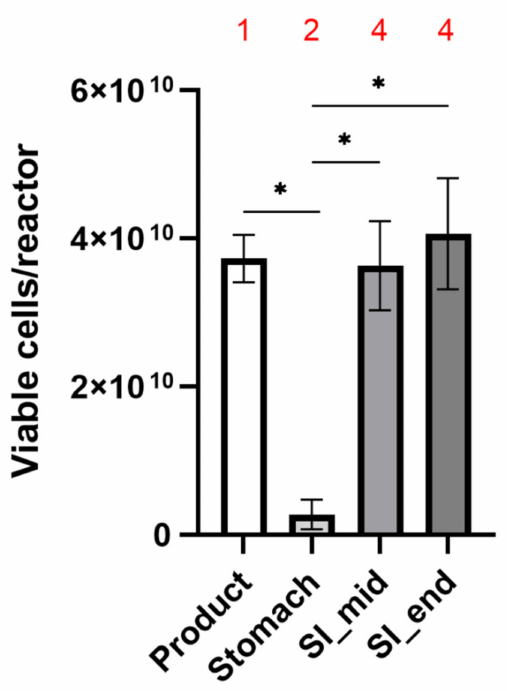
Figure 2. Probiotic survival during the upper gastrointestinal digestion in vitro. Bars represent the mean viable count ± SD ( n = 3) of microbial cells obtained by double live/dead staining and flow cytometry in the product and at different gastrointestinal compartments of the simulated digestion. SI mid = conditions mimicking middle of the small intestine; SI end = conditions mimicking the end of the small intestine. Statistically significant differences in different samples are indicated with asterisks (* p < 0.001). The visual scores of the capsules are indicated above the bars in red: (1) capsule intact; (2) capsule starting to degrade but most bacteria retained; (4) capsule fully